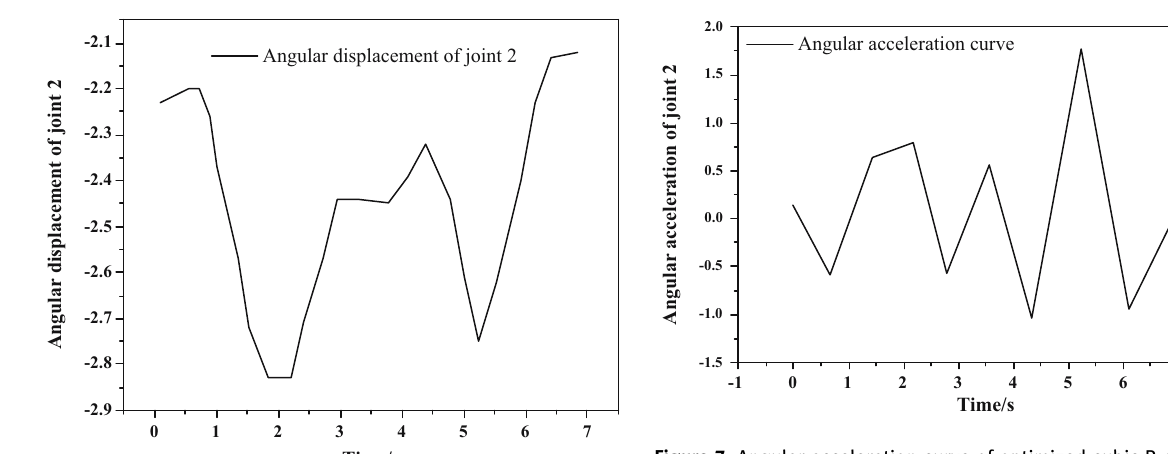
Figure 7: Angular acceleration curve of optimized cubic B - spline programming joint